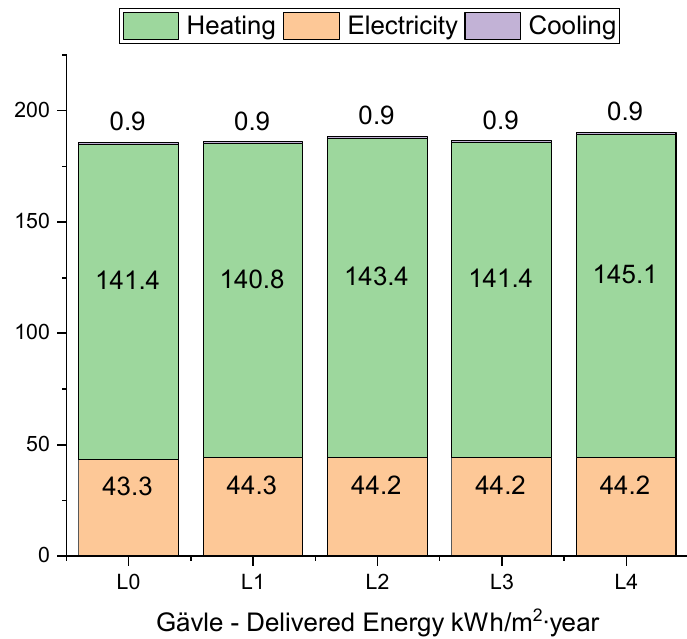
15 of 25 Figure 14. Breakdown of building’s annual energy usage for L0. When evaluating L0 − L4 which are the same as B0–B4 with the applied LEF, the re- sults in Figure 15 show that the required energy needed for heating was reduced for L0